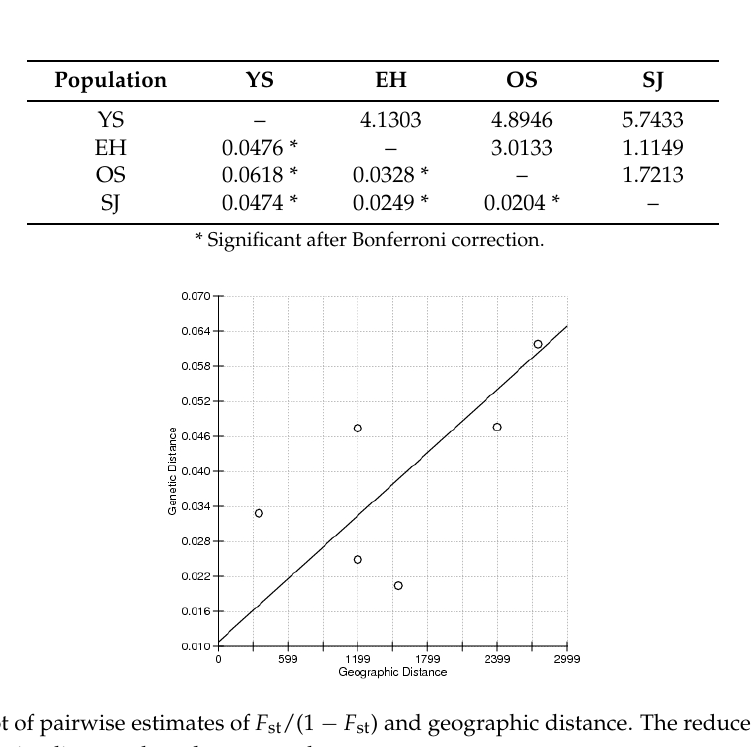
Table 1. Genetic diversity indices for Pacific cod.